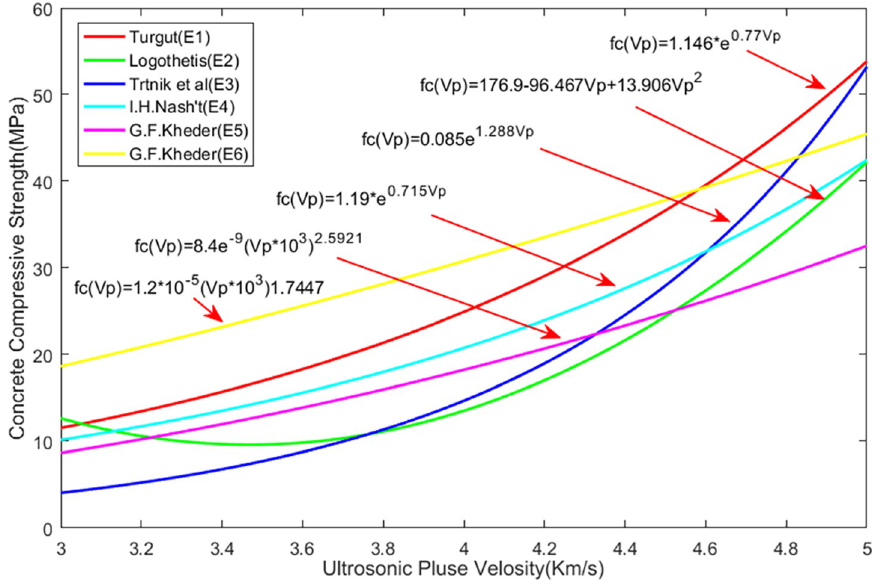
Fig 9. Calculation equations of UPV and compressive